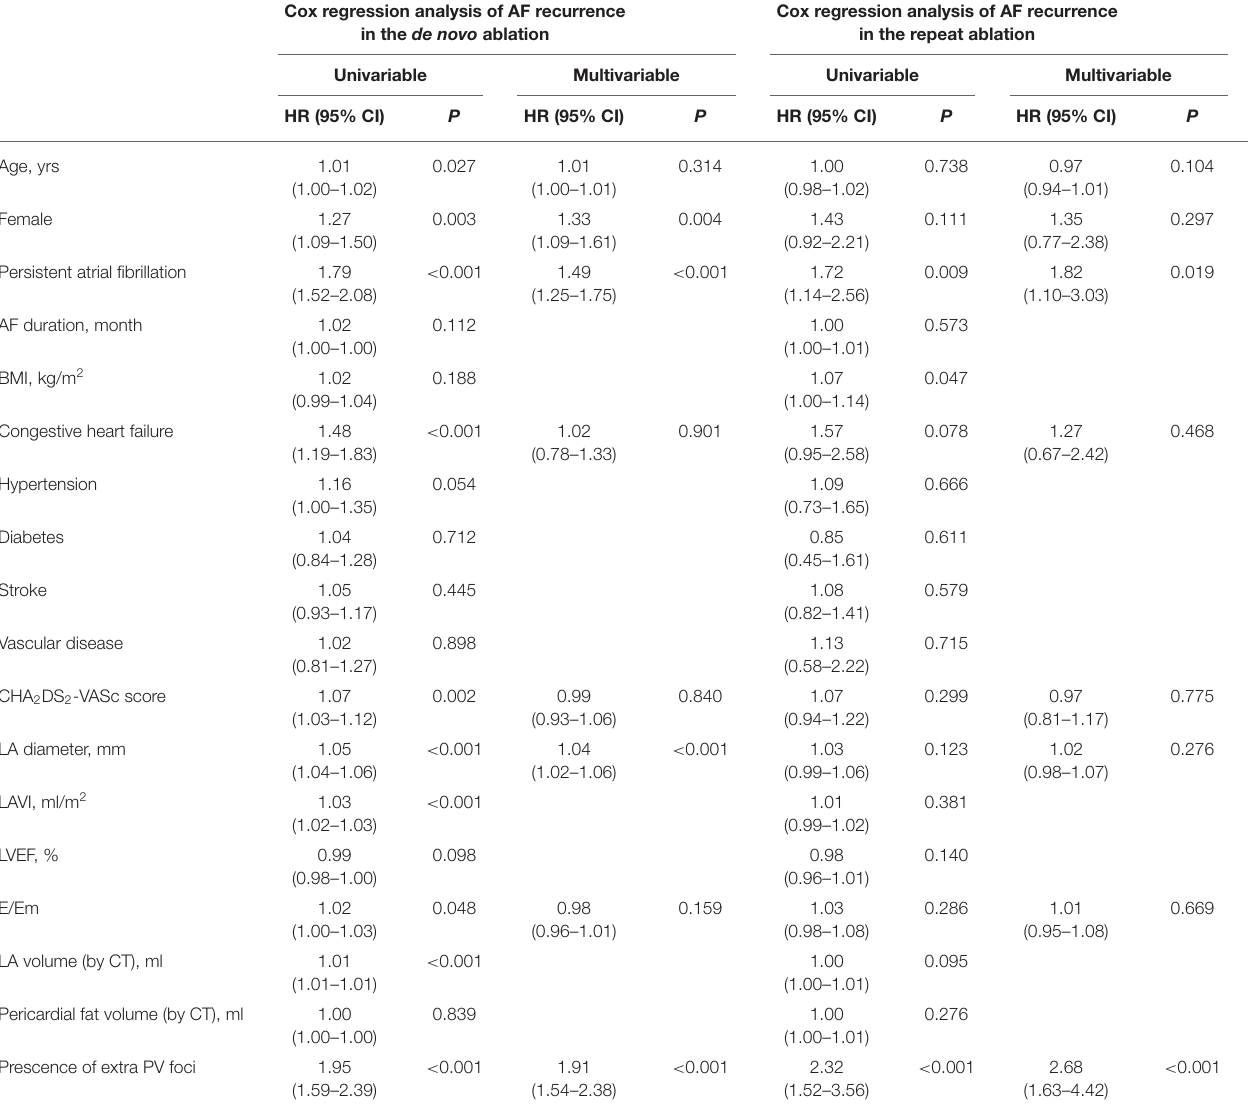
TABLE 5 | Cox regression analysis of AF recurrence after the de novo and repeat ablation procedures. Cox regression analysis of AF recurrence in the de novo